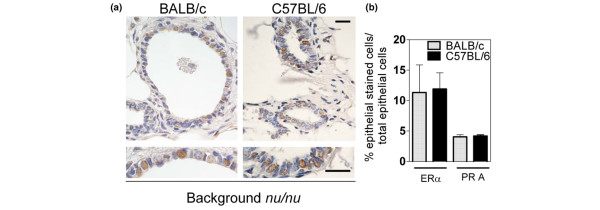
ER-α expression in reconstituted mammary glands. Epithelial mammary cells of BALB/c or C57BL/6 mice were purified and implanted into cleared fat pads of untreated nu/nu mice (as explained in Materials and methods). After 1 month, mammary glands were excised and fixed for histological evaluation. (a) ER-α was evaluated using MC 20 Santa Cruz antibody and PR-A (not shown) using C-20 Santa Cruz antibody (bar: 45 μm). (b) The number of stained cells is expressed as the percentage of stained cells among epithelial cells in 400× fields of every slide. ER, estrogen receptor; PR, progesterone receptor.